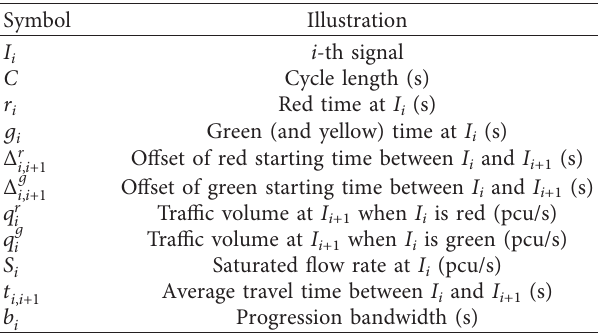
Table 1: Notations of model symbols and variables.